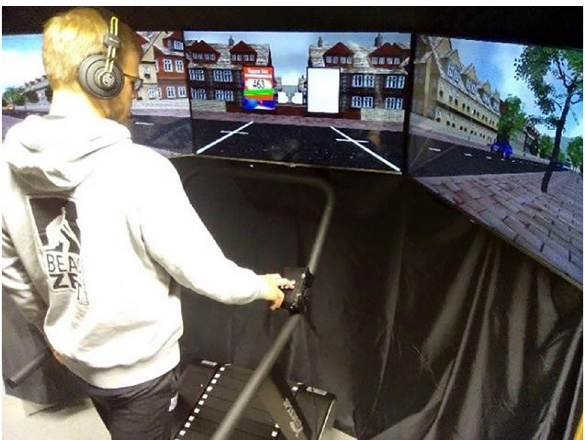
Figure 3. Street crossing simulator set up. Photograph of a participant walking on the treadmill through a virtual back alley towards a street. The participant wears headphone through which auditory stimuli are presented. The keyboard on which the manual responses are given is installed on the right side of the treadmill. Figure reprinted from "Cognitive-motor interference in an ecologically valid street crossing scenario",